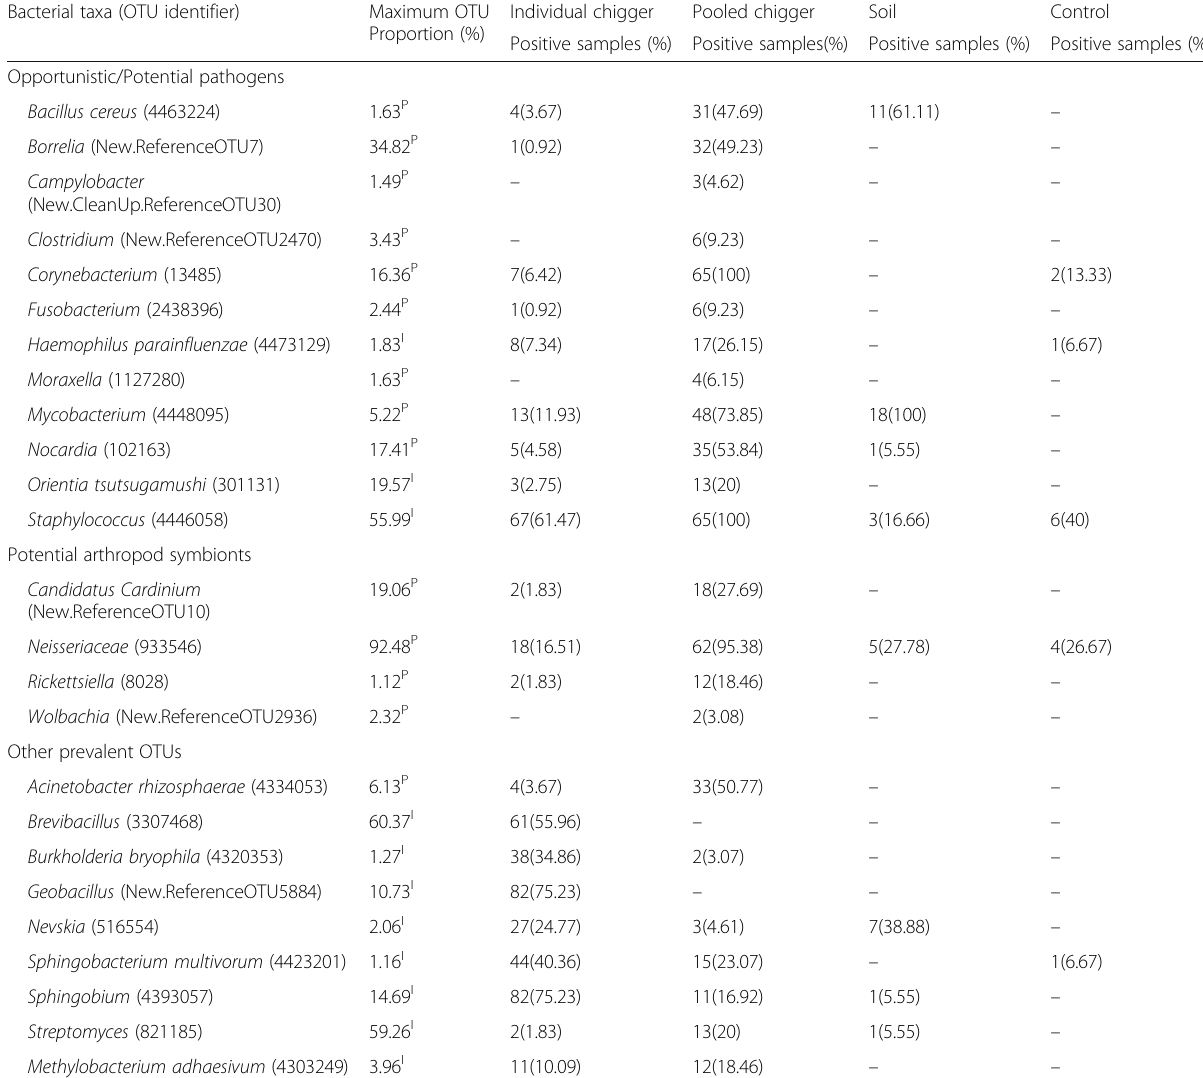
Table 1 Selected bacterial taxa of public health importance, potential symbionts, and other prevalent OTUs detected in individual and pooled chiggers in comparison to soils and background controls Bacterial taxa (OTU